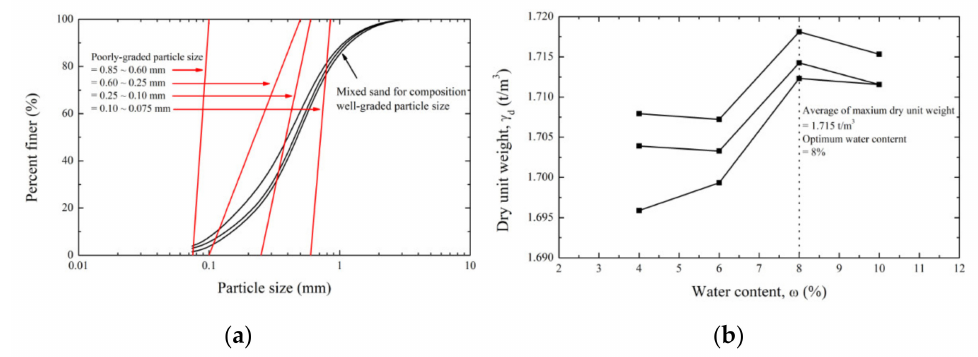
Figure 4. Results of laboratory test conducted using mixed well-graded sand: ( a ) particle size distribution obtained from sieve test and ( b ) compaction test to determine maximum dry unit weight and optimal water content of well-graded